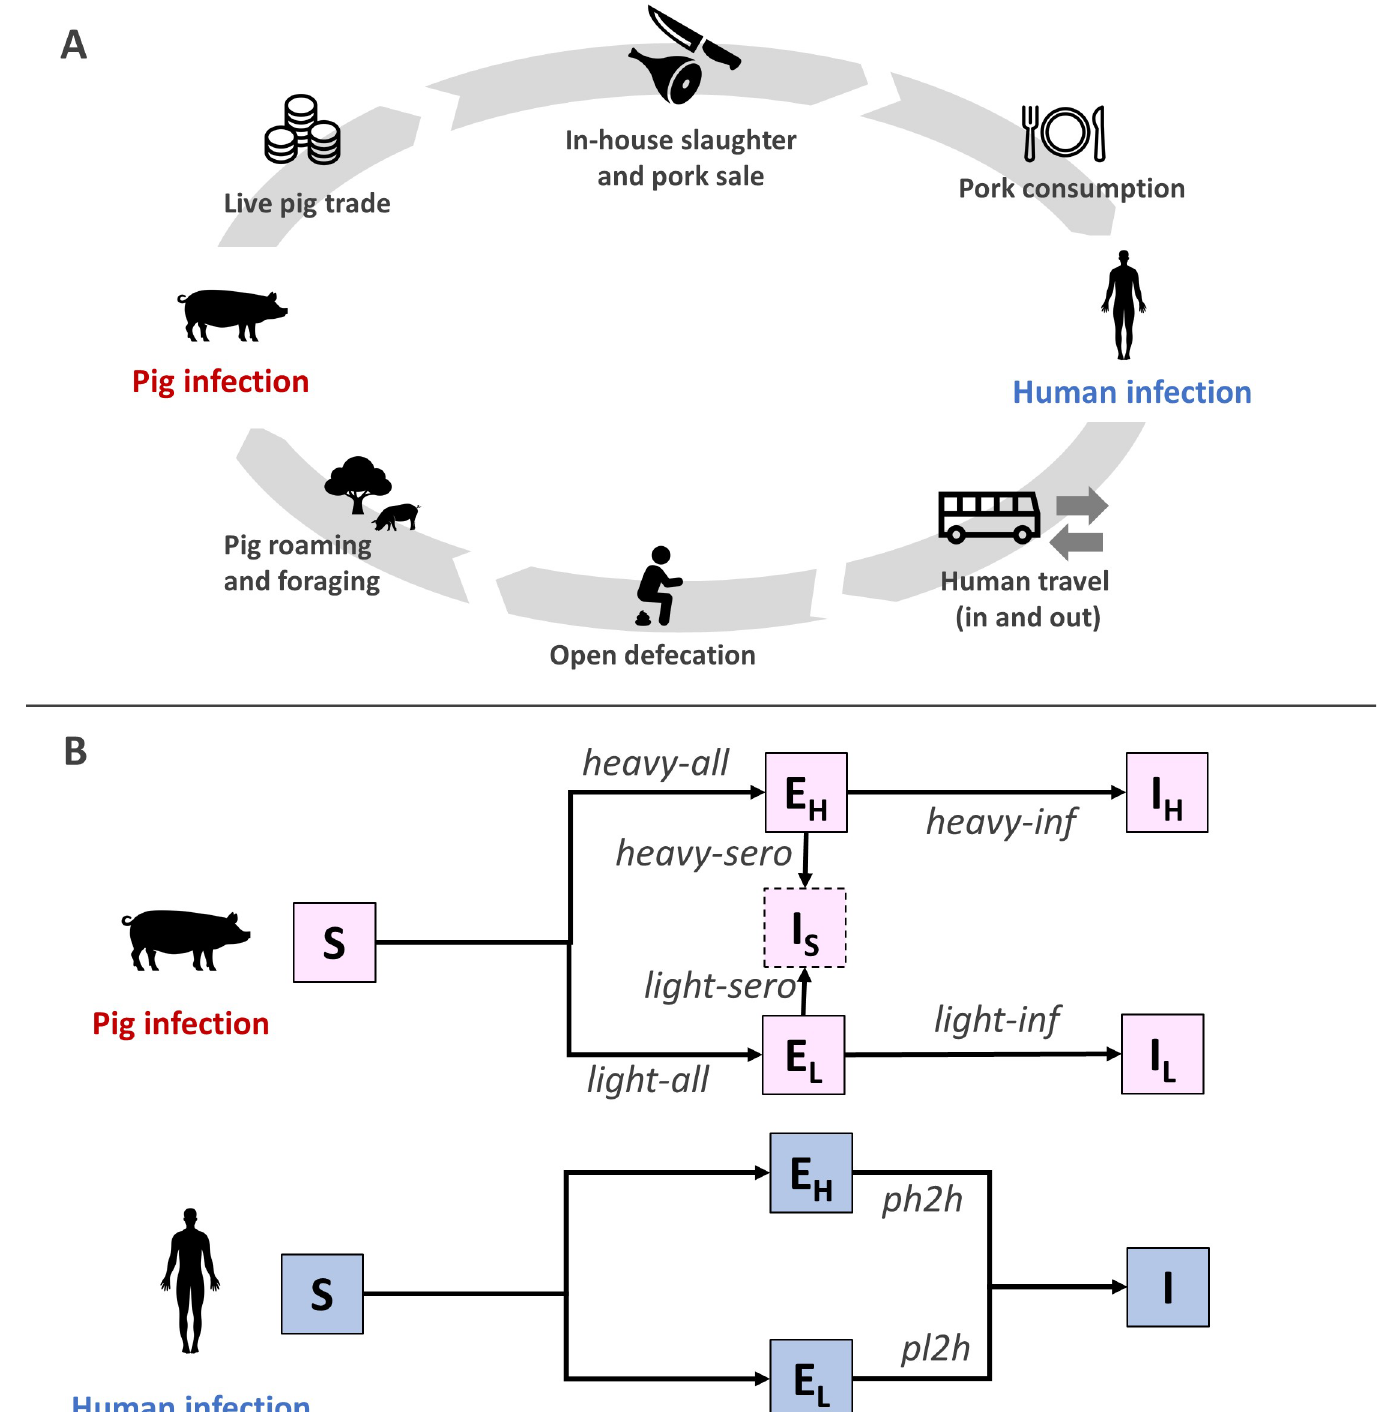
Fig 1. Transmission of Taenia solium in CystiAgent. Panel A (top): 1) Live pig trade: infected (live) pigs are sold to other households inside and outside the village, and imported from outside; 2) in-house slaughter and sale of pork to other households 3) pork consumption: potentially infected pork is consumed by household members; 4) human infection (see panel B for details); 5) human travel: humans travel to other endemic villages where they may acquire tapeworm infections through pork consumption; 6) open defecation: humans may practice open outdoor defecation; 7) pig roaming and foraging: free-roaming pigs consume potentially infectious eggs present in the environment; 8) pig infection (see panel B for details). Panel B (bottom): Susceptible pigs (S) may be heavily exposed (E H ) by consuming T . solium proglottid segments in the environment or through the stochastic parameter heavy-all , which is a probability of exposure applied to all pigs, or be lightly exposed (E L ) by consuming